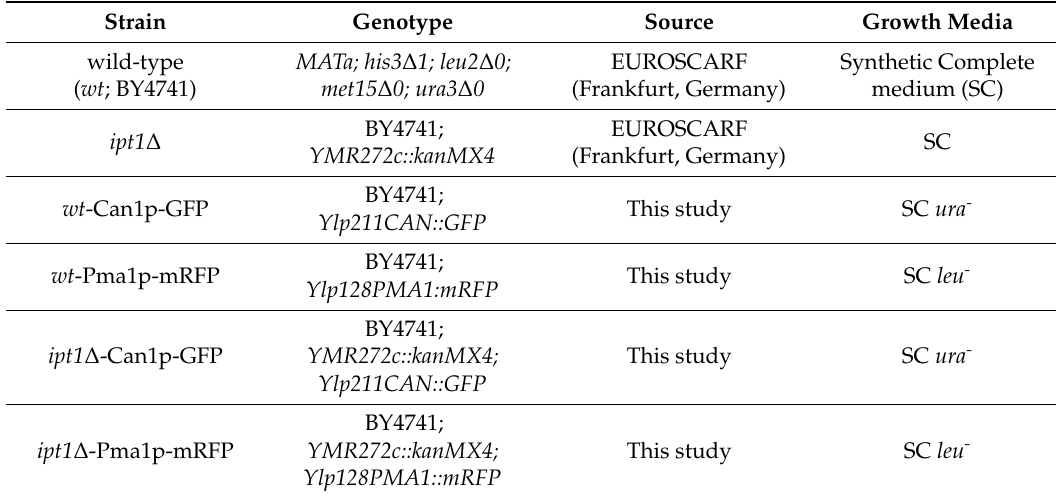
Table 1. Saccharomyces cerevisiae strains used in this work, genotype description, and growth media. Strain Genotype